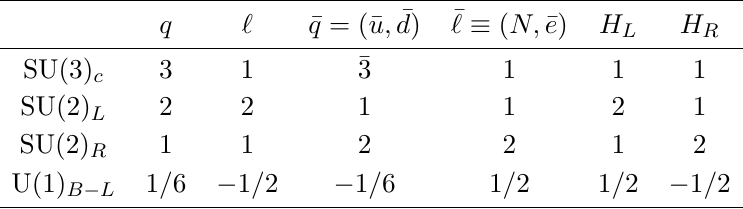
Table 1 . The gauge charges of quarks, leptons, H L , and H R